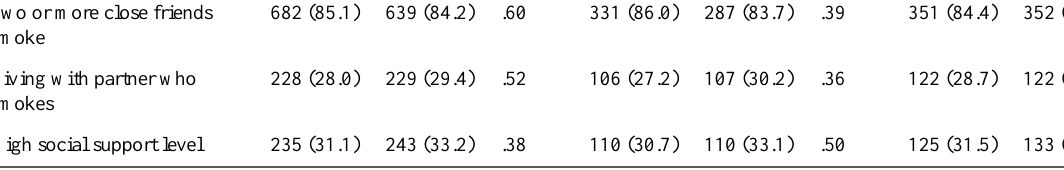
Remaining participantsParticipants lost to follow-upAll participantsBaseline